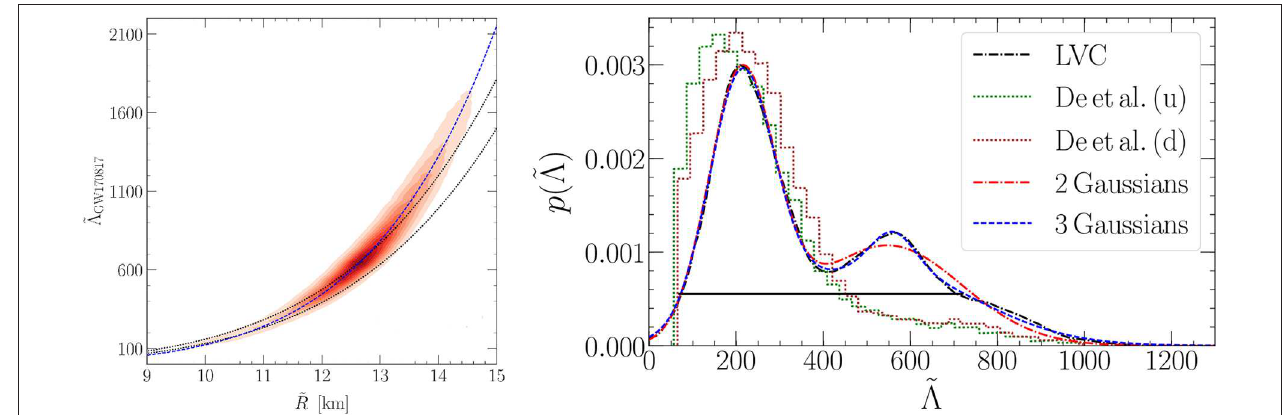
FIGURE 2 | Left : Correlation between the average radius ˜ R of the two neutron stars in GW170817 and the binary tidal polarizability ˜ 3 GW170817 . We show the distribution for the EOS models of Tews et al. [50] (red shaded area), a fit to this distribution (blue dashed line), as well as the result from Equation (5) of De et al. [51] with uncertainty (black dotted lines). Right : Marginalized and normalized posterior probability distribution p ( ˜ 3 ) for GW170817 from the LVC (black dashed-dotted line), from the analysis of De et al. [ 51] for the two extreme cases [uniform mass prior (u) and mass prior informed by double neutron stars (d)] (green and red dotted lines), and fits to the LVC distribution of Tews et al. [50] (red dashed-dotted and blue dashed lines). Reprinted by permission from Springer Nature, Tews et al. [50], copyright